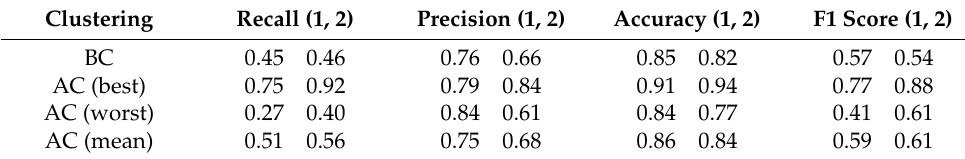
Table 2. Four performance results of LSTM with training data type [Genre*ATV].